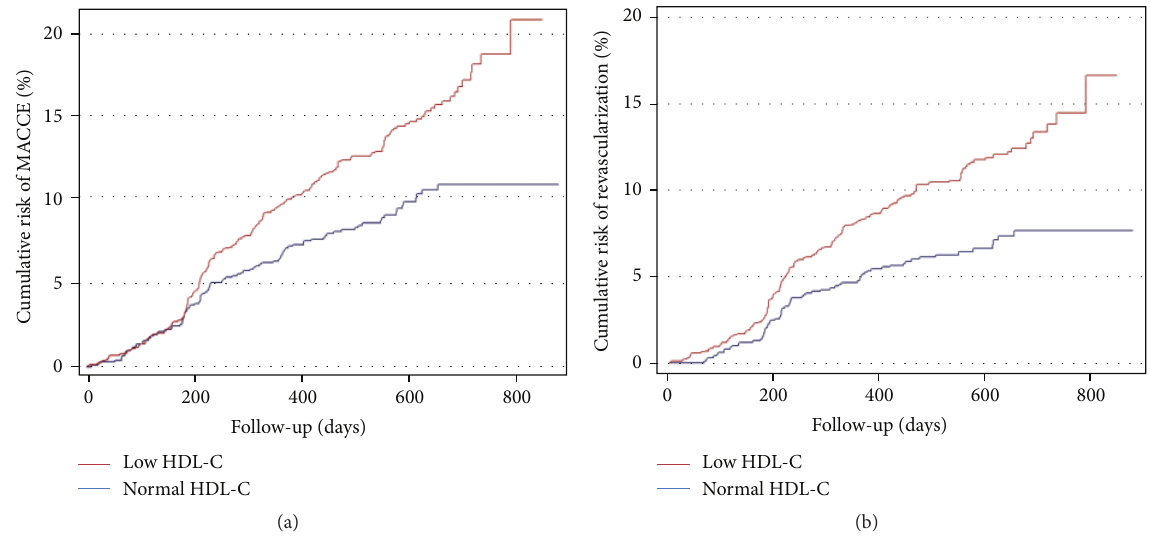
Figure 1: Kaplan-Meier curve of cumulative risk of (a) MACCE (major adverse cardiovascular cerebrovascular events) and (b) revascularization when subjects were grouped according to the HDL-C